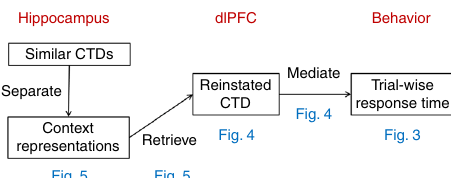
Fig. 1 Proposed neurocognitive processes underlying the reinstatement of learned CTD. Blue text indicates the fi gures where relevant results are